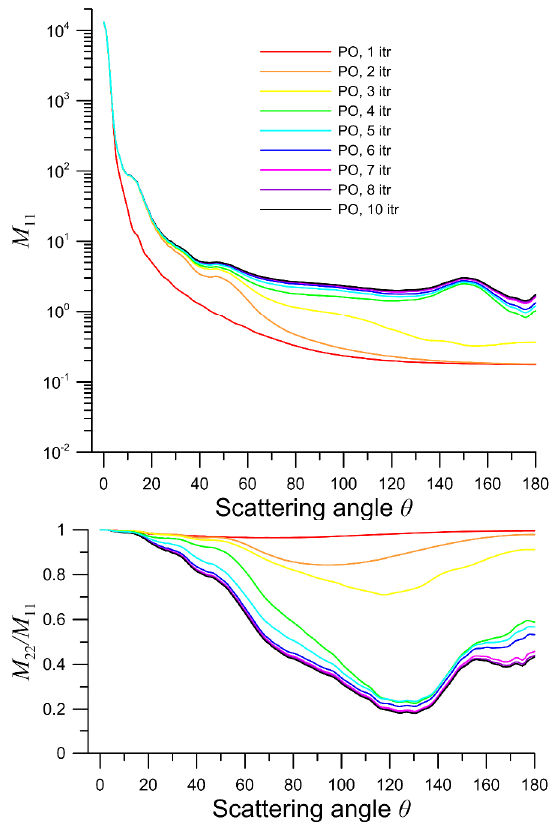
Figure 4. Element of the Mueller matrix depending on the number of iteration.